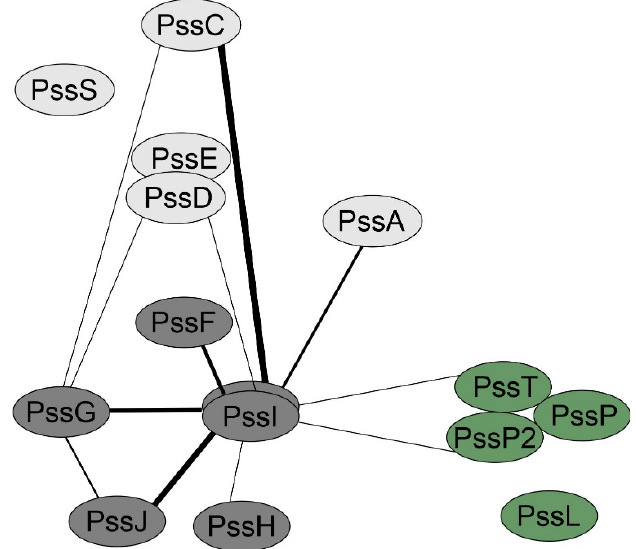
Figure 7. PssG and PssI interaction network created based on the bacterial two-hybrid screening results. The thickness of the lines connecting proteins is proportional to the number of pairs with significant activities from among all tested for any given protein pair. Activity values ± SD for all the tested fusion protein pairs were given in Supplementary Figure S1.